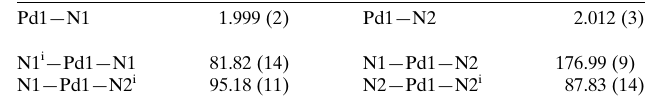
Table 1 Selected geometric parameters (A˚ , (cid:3) ).